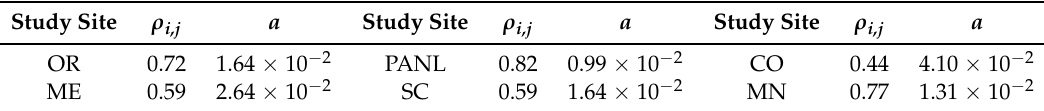
Table 4. Simulated spatial autocorrelation between two square plots center-points at 20 m distance for AGB variable for each study